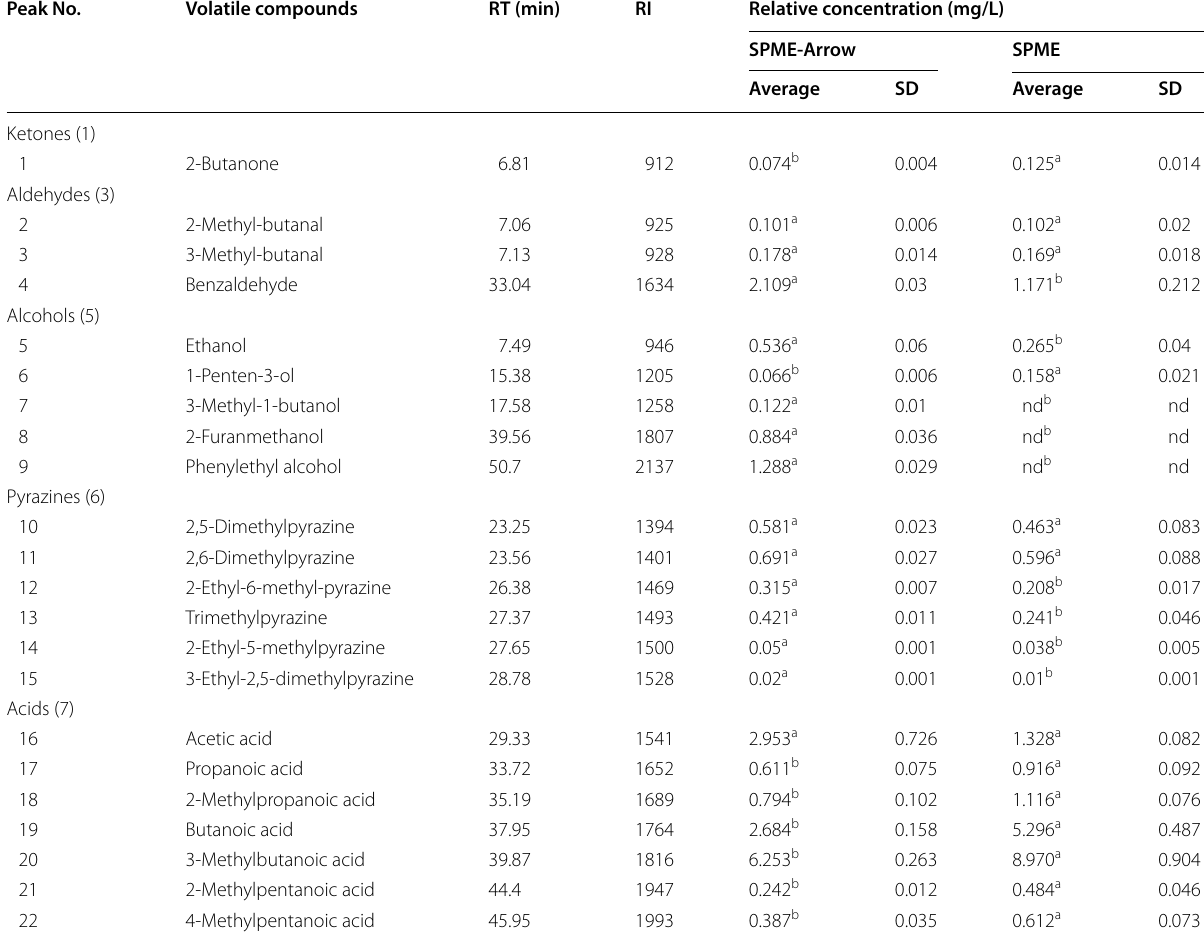
RT retention time, RI retention index—used for identification by GC–MS (DB-WAX column), Relative concentrations of volatile compounds are expressed as equivalents of the internal standard (2 mg/L of 4-methyl-2-pentanol) for SPME-Arrow and SPME–GC/MS, nd not detected Data represent mean SD (n 3). Different letters (a and b) represent significant differences (P < 0.05) using ANOVA and Duncan’s multiple range test. ± =